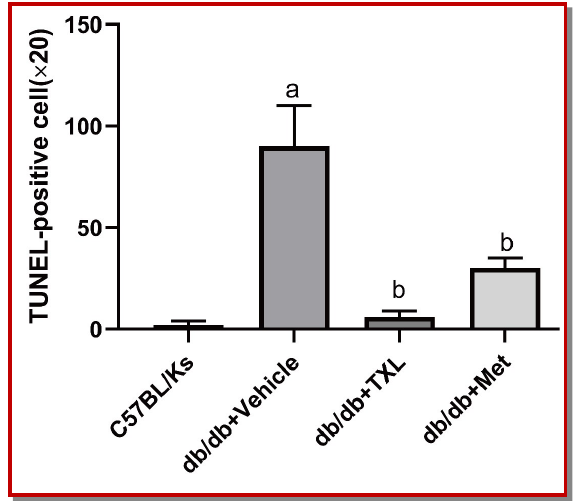
Figure 3: TUNEL-positive tubular epithelial cells in different group. a p<0.05 compared with C57BL/Ks control and b p<0.05 compared with undertreated db/db mice (model group)